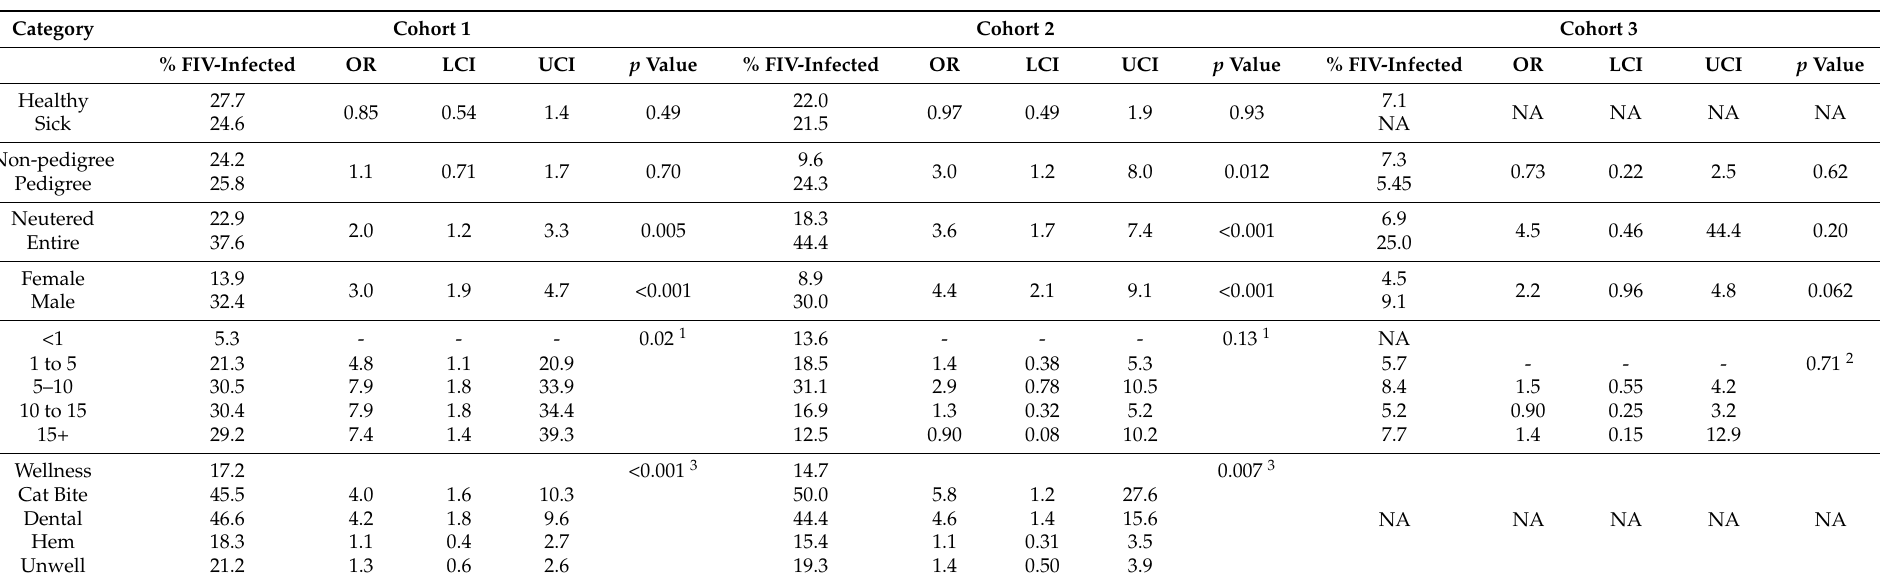
Table 3. Analysis of possible risk factors for FIV infection in cohort 1 ( n = 525; in-house hematology and blood biochemistry testing), cohort 2 ( n = 282; external hematology and blood biochemistry testing) and cohort 3 ( n = 425; FIV vaccine efficacy study). OR = odds ratio, LCI = lower confidence interval, UCI =